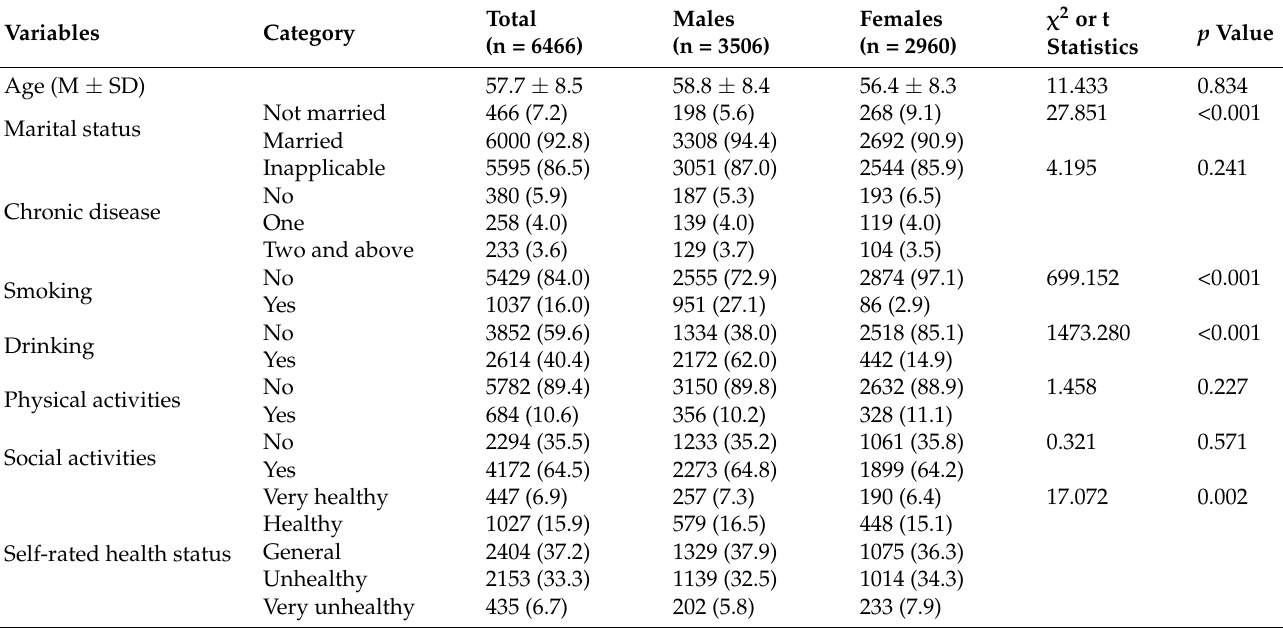
Table 1. Demographic characteristics of the participants (n =